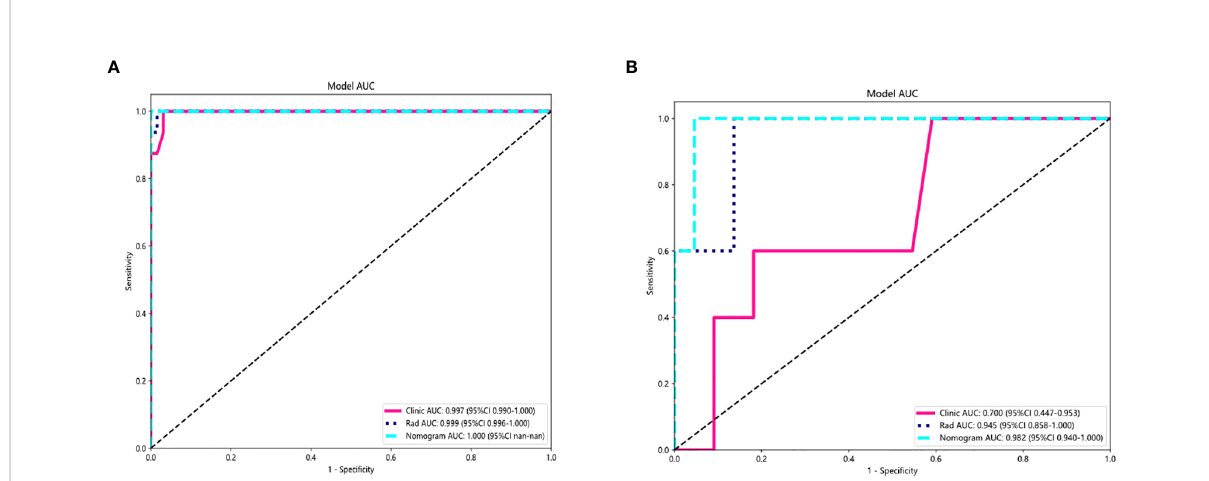
FIGURE 5 AUC Comparison of clinical, radiological, and nomogram models in the training (A) and testing (B) cohorts. The combined nomogram performed optimally in both the training and testing